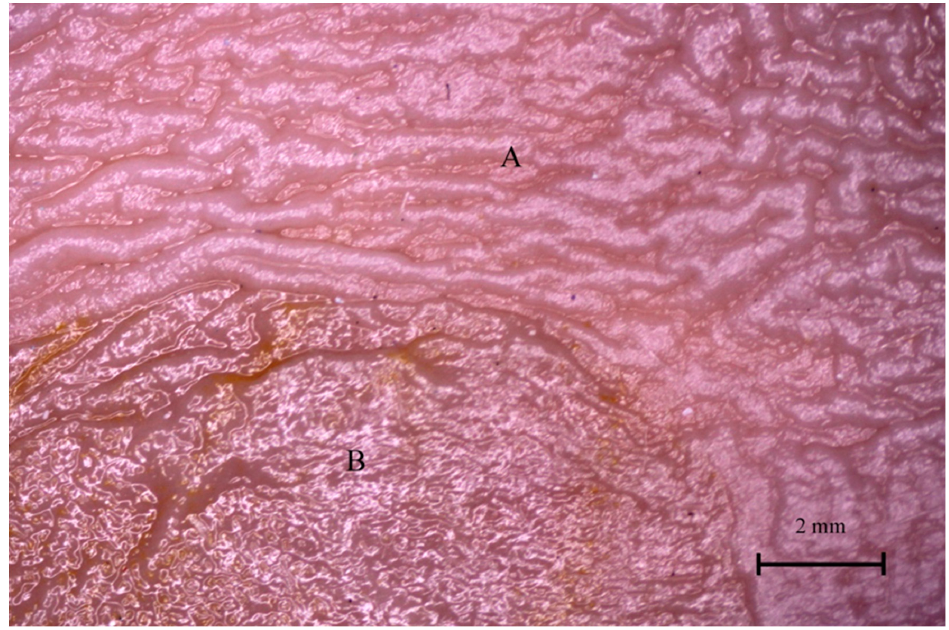
Figure 13. Gastric mucosa in the plicated edge margin region (the second age group). A—non-glandular part, B—glandular part.